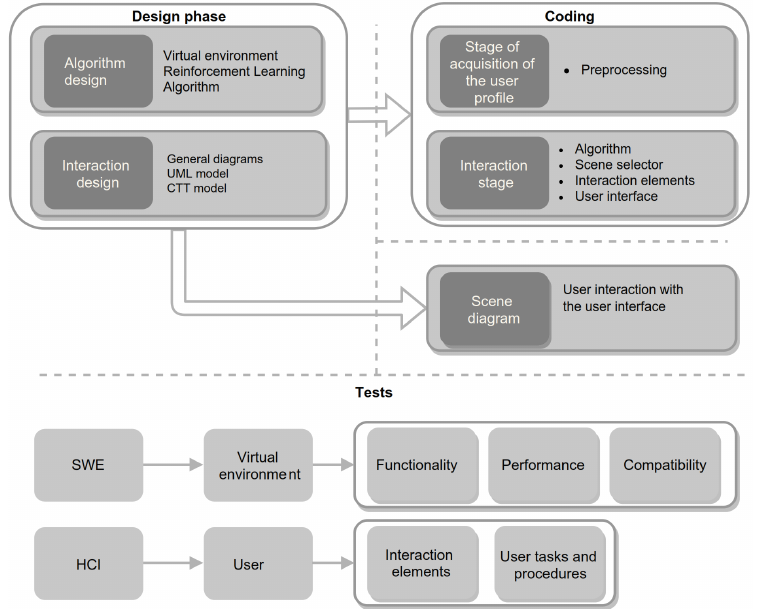
Figure 10. Implementation phase of proposed